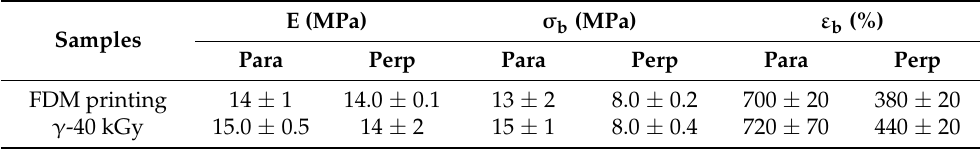
Figure 4. ( a ) Tensile curves for FDM processed and sterilized TPU samples; and ( b ) dumbbells cut in the perpendicular and parallel directions to the printing layers (red lines represent locations of breaking). Table 3. Data (n = 3) from tensile curves: Young’s modulus (E), stress at break ( σ b ) and strain at break ( ε b ) (mean ± SD).